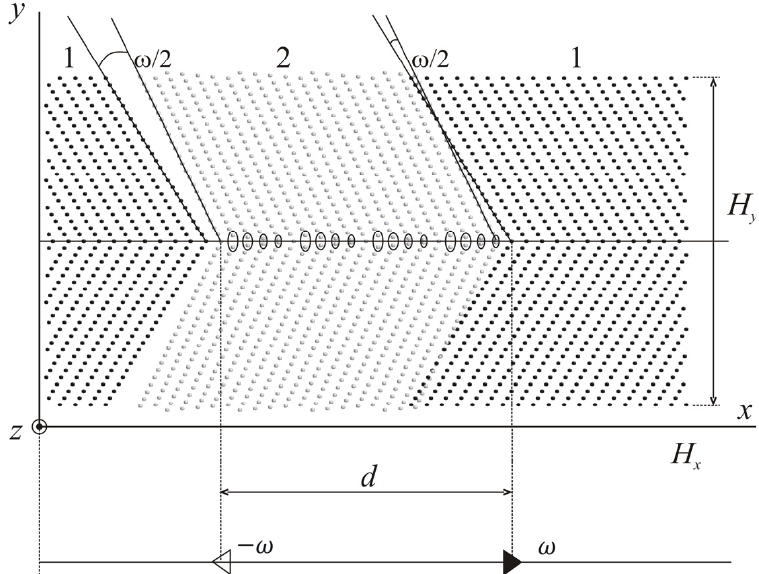
Figure 21. Schematics of the construction of a computational cell [118] by using two bicrystals ( Σ = 11/ θ 1 = 62.96 ◦ (1) and Σ = 31/ θ 2 = 52.20 ◦